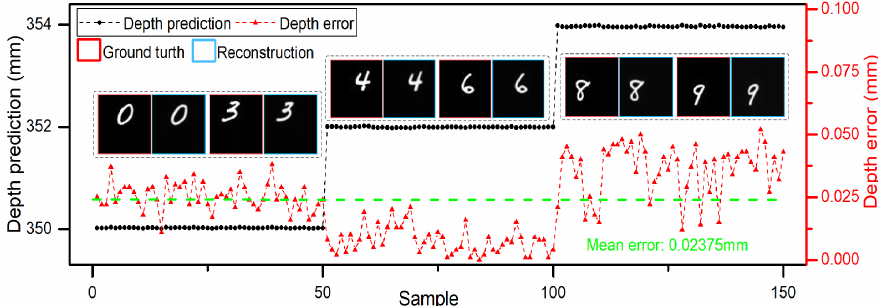
Figure 4. Locating and imaging results with no-fixed position objects in a